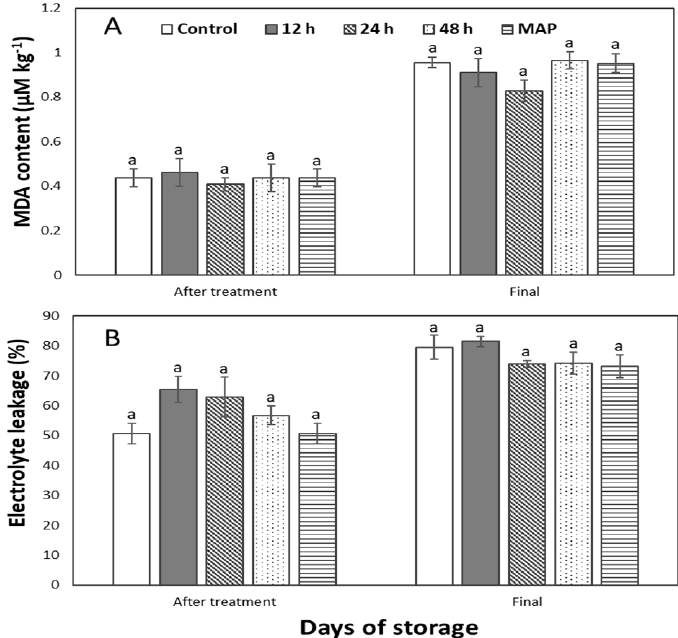
Figure 5. Malondialdehyde (MDA) content ( A ) and electrolyte leakage ( B ) of sweet peppers pre-treated with 10% CO 2 for 12, 24, and 48 h, as well as untreated and modified atmosphere packaging (MAP) with 50,000 cc · m − 2 · day − 1 · atm − 1 OTR film after treatments and the last day of storage. The vertical bars represent ± SE of n = 4, and different letters indicate a significant difference at p < 0.05.